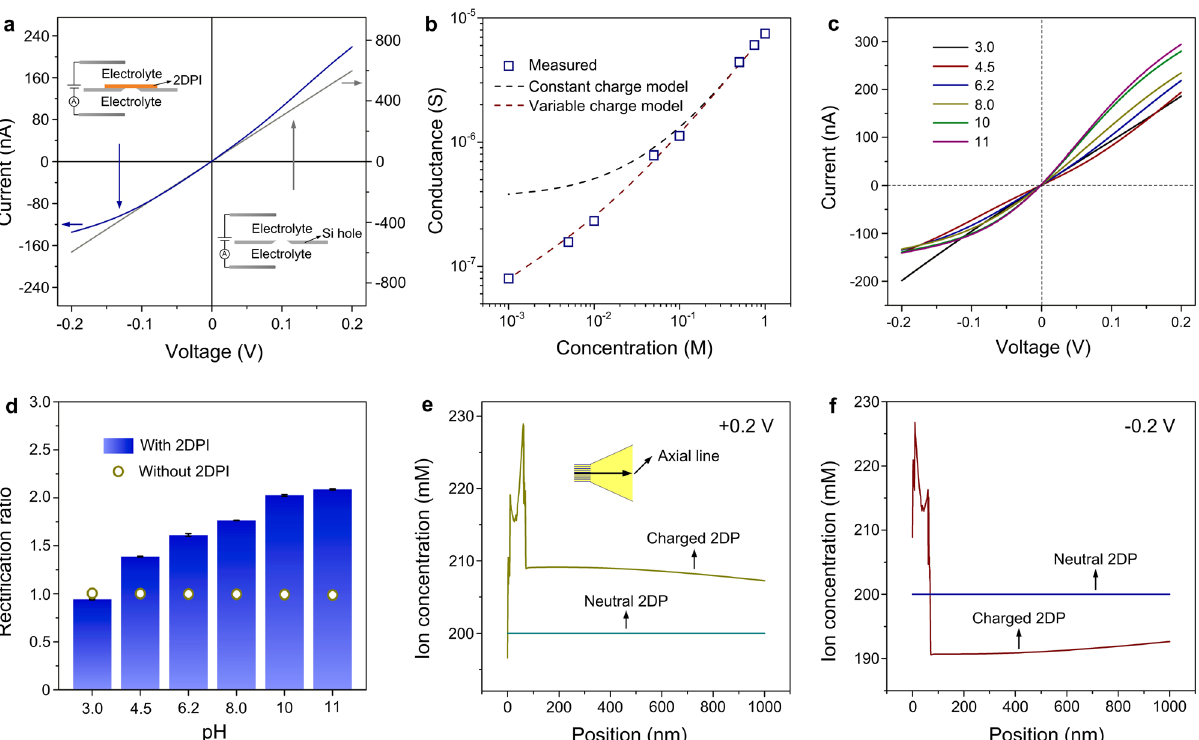
Fig. 2 Surface-charge-governed ion transport. a I – V curves of the silicon hole before and after deposition with 2DPI membrane recorded in 0.1 M KCl. b Transmembrane conductance as the function of electrolyte concentration. The red line denotes the fi tted values with variable surface charge density and the black line represents values assuming constant surface charge – 12 mC m − 2 . c I – V curves of the 2DPI membrane recorded in 0.1 M KCl of different pH values. d Variations of the recti fi cation ratio of the silicon hole before and after deposition with 2DPI membrane in response to pH value. e , f The total ion concentration on the axial line of two representative models that simulate the neutral 2DP deposited substrate and charged 2DP deposited substrate under + 0.2 V ( e ) and − 0.2 V ( f ). Error bars represent